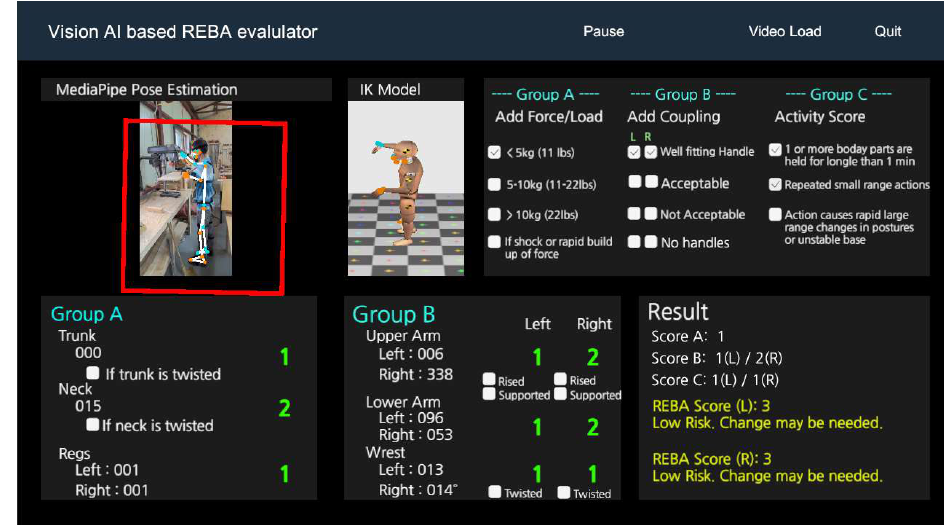
Figure 30. Evaluation of drilling machine working posture.